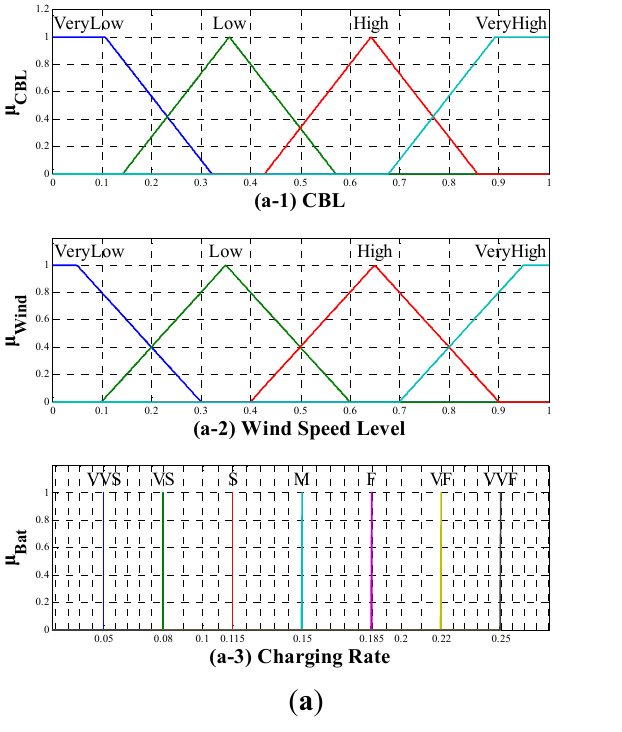
Figure 10. Membership functions: ( a ) Fuzzy membership function for BESS charging in State “2”; ( b ) Fuzzy membership function for BESS discharging in State